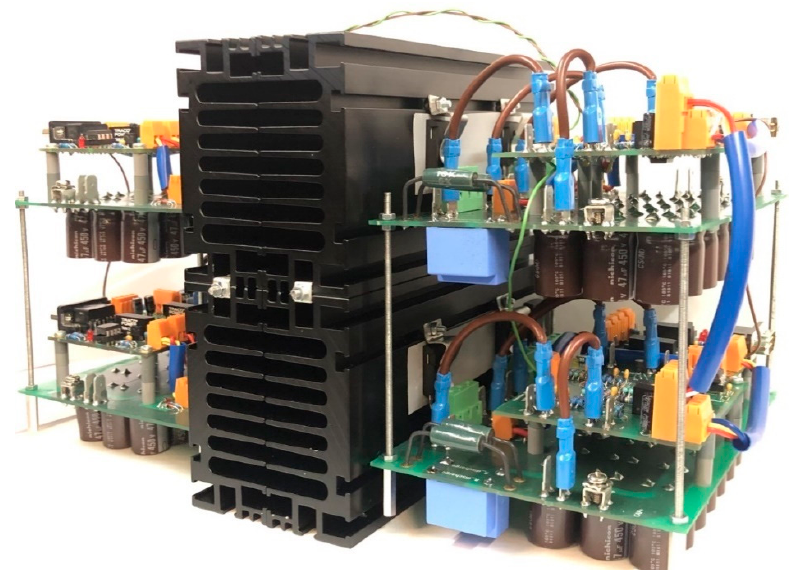
Figure 12. Single MMC leg/phase (four submodules).